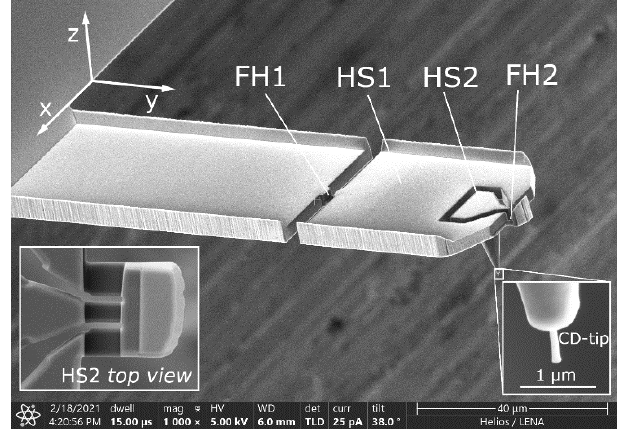
Figure 2. Scanning electron microscope image of a manufactured 3D-Nanoprobe with two flexure hinges (FH 1 and FH2) and two head sections (HS1 and HS2), the details show the CD tip with the flared tip apex and the structure of HS2.